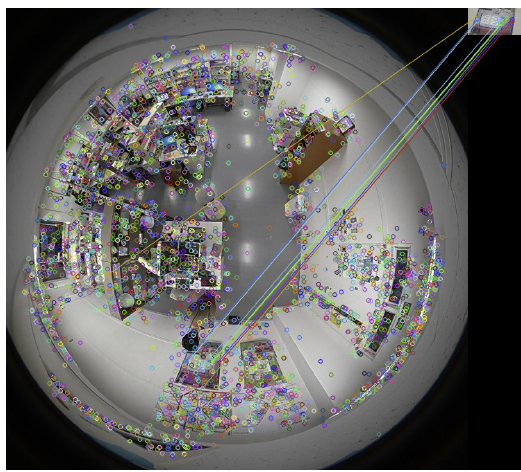
Figure 3. Second stage of image matching.